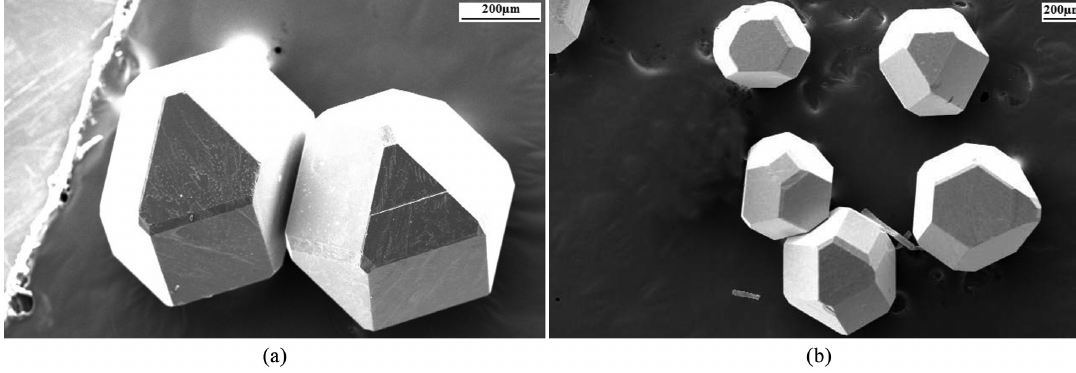
Figure 4. Diamonds (a) uncoated and (b) with Ti coating, prior to heat treatment.